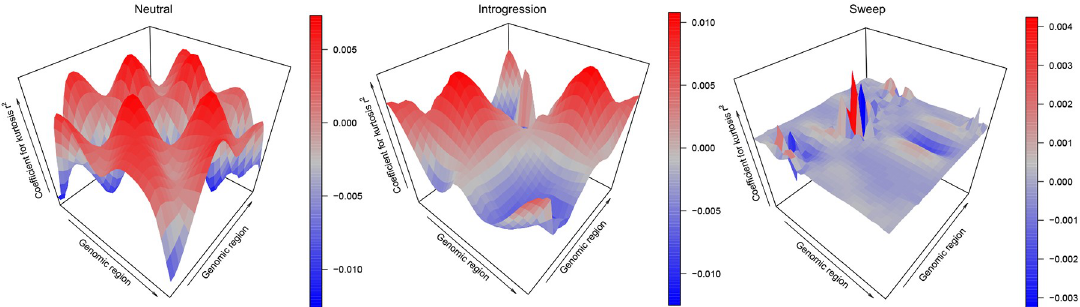
Fig 5. Three dimensional representations of reconstructed wavelets from regression coefficients ( β s) when differentiating among adaptive introgression, sweeps, and neutrality for summary statistics kurtosis of pairwise r 2 for SURFDAWave when γ = 1, when trained with statistics ^ p , H 1 , H 12 , H 2 / H 1 , frequencies of first to fifth most common haplotypes, and mean, variance, skewness, and kurtosis of pairwise r 2 . SURFDAWave was trained on simulations of scenarios simulated under demographic specifications for European CEU demographic history. Note that the wavelet reconstructions for all summary statistics are plotted on the same scale, thereby making the distributions of some summaries difficult to decipher as their magnitudes are relatively small. SURFDAWave results shown are using Daubechies’ least-asymmetric wavelets to estimate spatial distributions of summary statistics. Level chosen through cross validation.